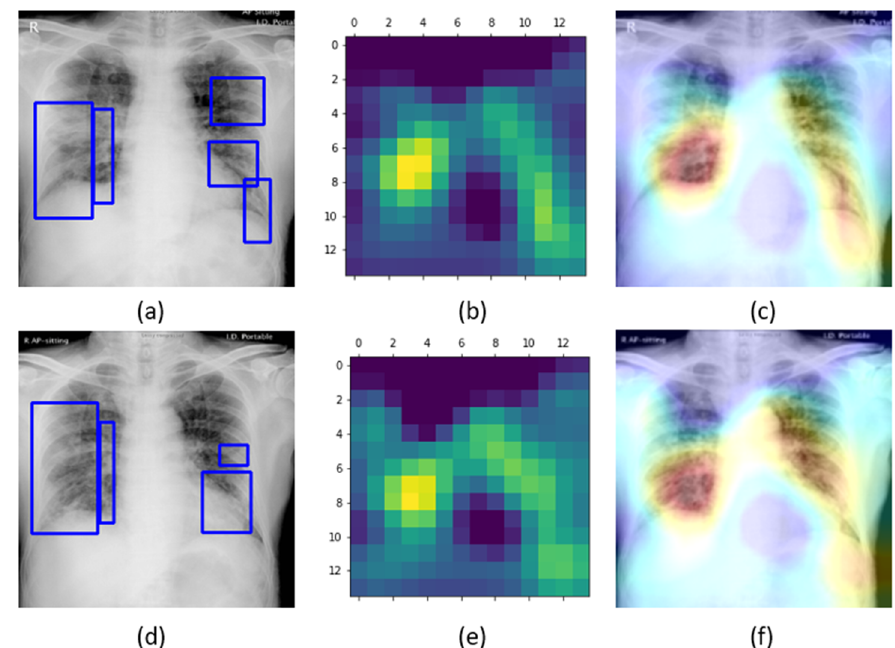
Figure 8. Original CXRs, heat maps, and salient ROI visualization: ( a – c ) show a sample Montreal-COVID-19 CXR with GT annotations, the corresponding heat map, and Grad-CAM visualization; ( d – f ) show a sample Twitter-COVID-19 CXR with GT annotations, the heat map, and its associated class activation maps. Blue frames in ( a , d ) denote radiologist annotations indicating disease regions, which serve as ground truth in our analysis.